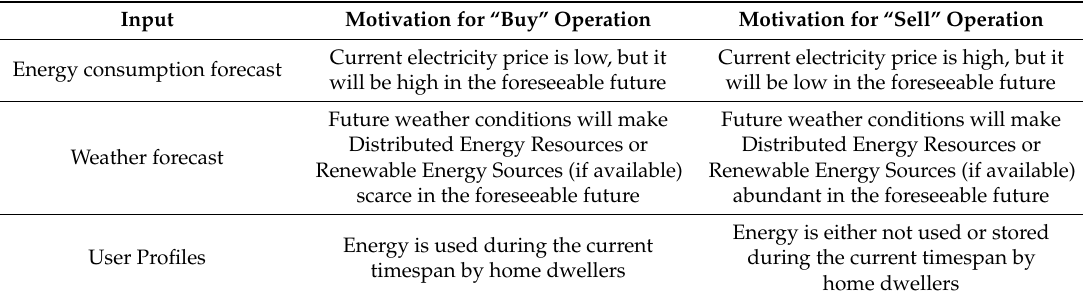
Table 3. Algorithm activities and